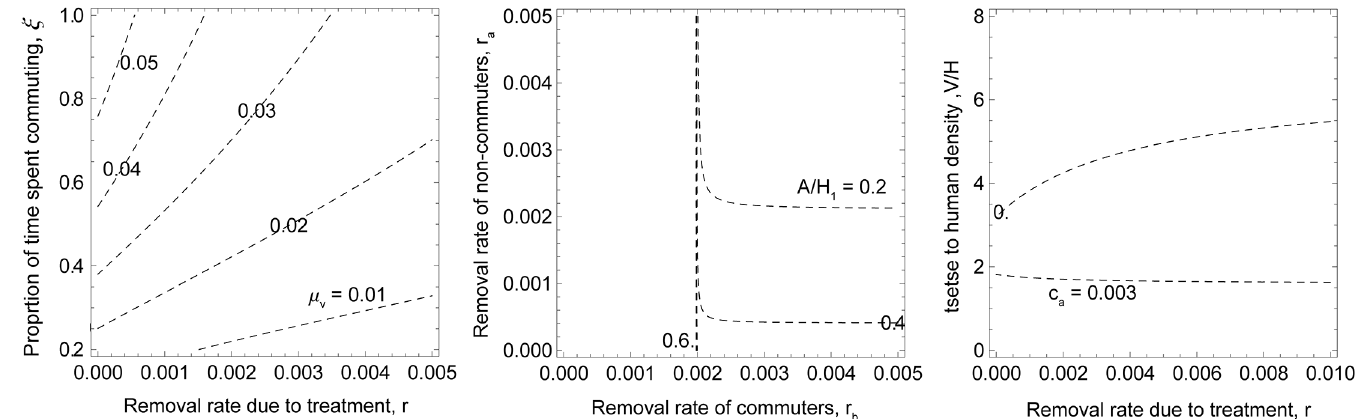
Fig 3. Zero-growth isoclines ( R 0 = 1) of T . b . gambiense under perturbation of specific parameters. The parameter values used were the median values obtained for the high transmission setting, except for those varied in the analysis. In the left plot, isoclines at different levels of vector mortality are shown, depending on the daily removal rate of infected humans ( r ) and the proportion of time commuters spend in the high exposure area ( ξ ). The areas above the isoclines represent values of R 0 greater than 1, and below and to the right of the isoclines values smaller than 1. In the middle plot the impact of screening humans in the low risk setting ( r a ) in combination with screening commuting humans ( r b ) is shown for different levels of animal to human ratios (A/ H 1 ). In the right plot isoclines are depicted along removal rates ( r ) and tsetse density (V/H) in both areas when animals either do not contribute to transmission ( c a = 0) or they can infect tsetse ( c a =